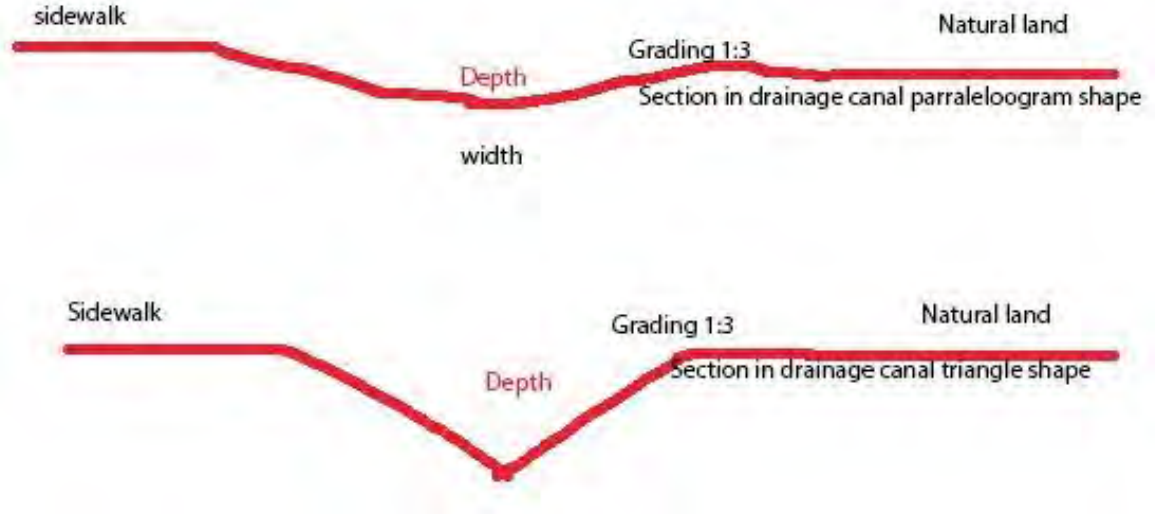
Fig 20: Drainage channels, Egyptian rule No. 159 of 1998. (the